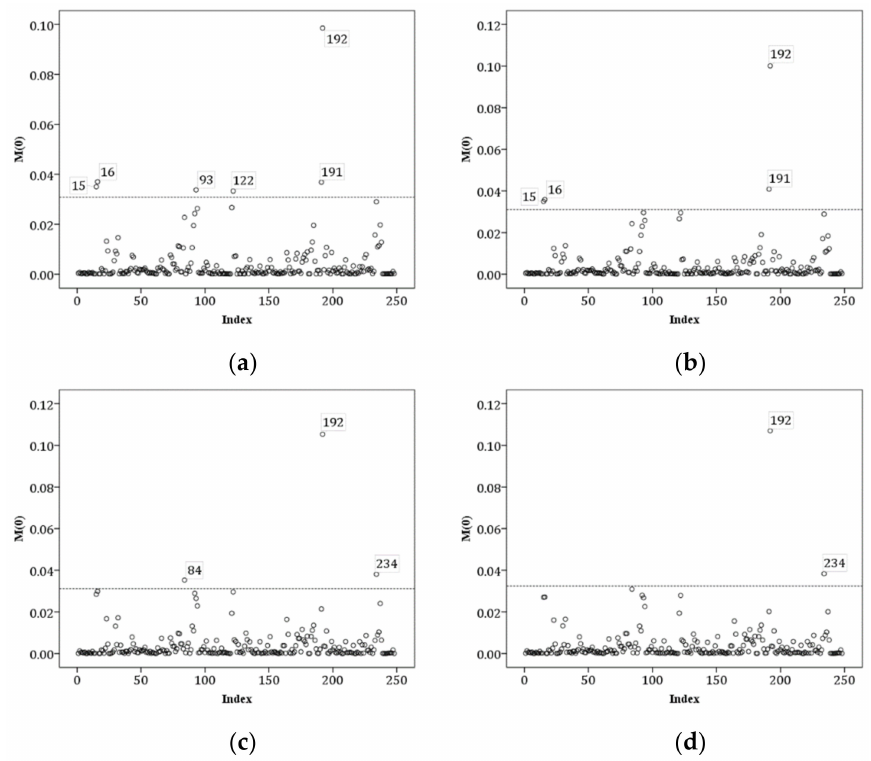
Figure 6. Index plots of M (0) for the perturbation of the second column of X for the four scenarios. Dotted lines show the yardstick for M (0) with c ∗ =